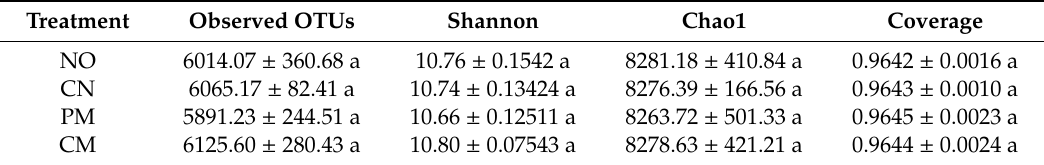
Table 4. Estimated number of observed OTUs and the biodiversity, richness, and coverage of each